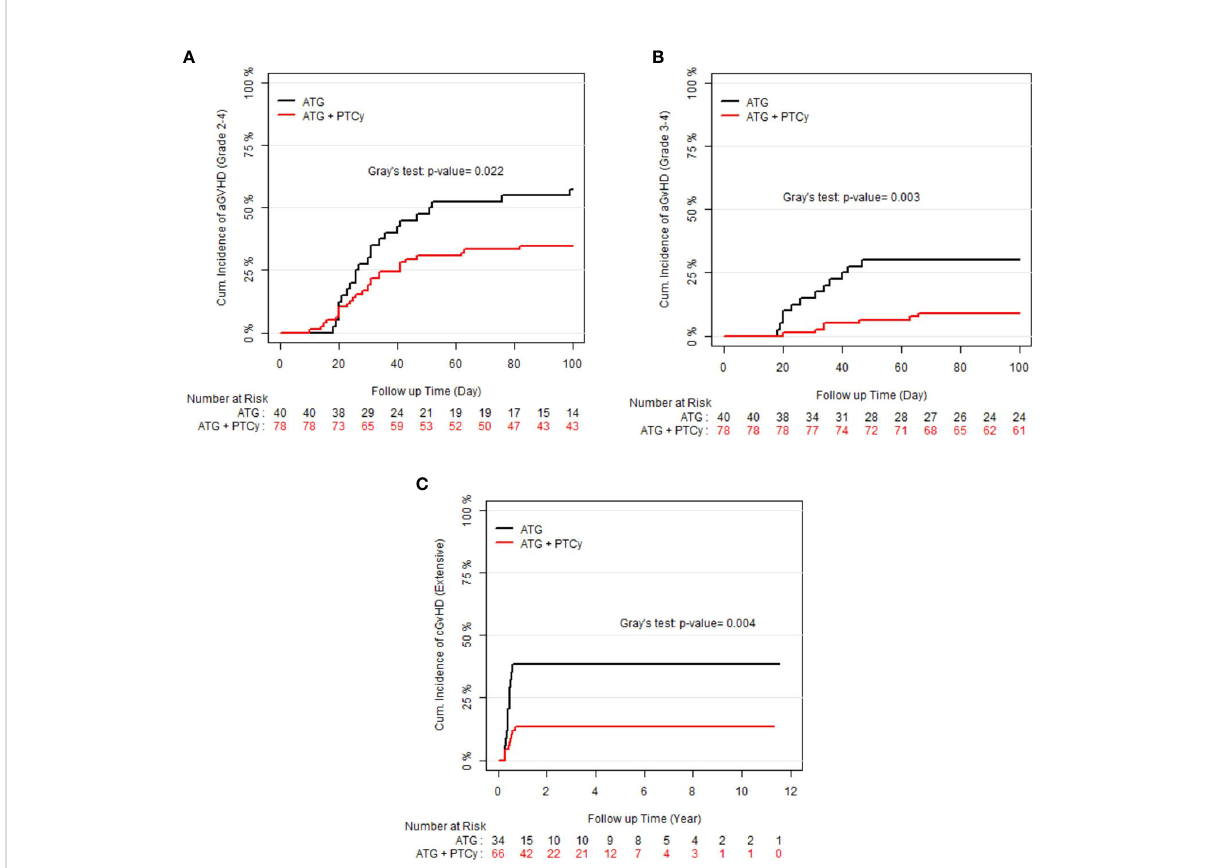
FIGURE 1 Cumulative incidence (CI) of graft-versus-host disease (GvHD) according to treatment groups; (A) CI of grade II – IV acute GvHD; (B) CI of grade III – IV acute GvHD; (C) CI of extensive chronic